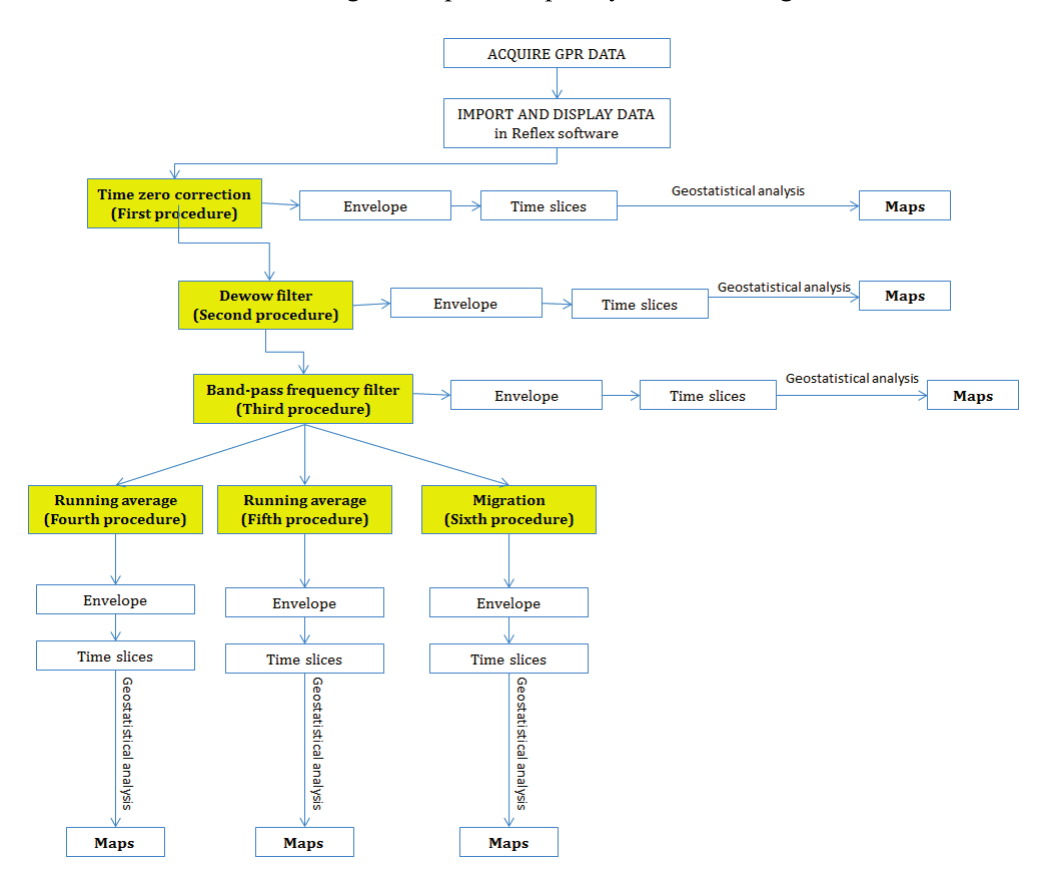
Figure 2. A schematic representation of GPR data